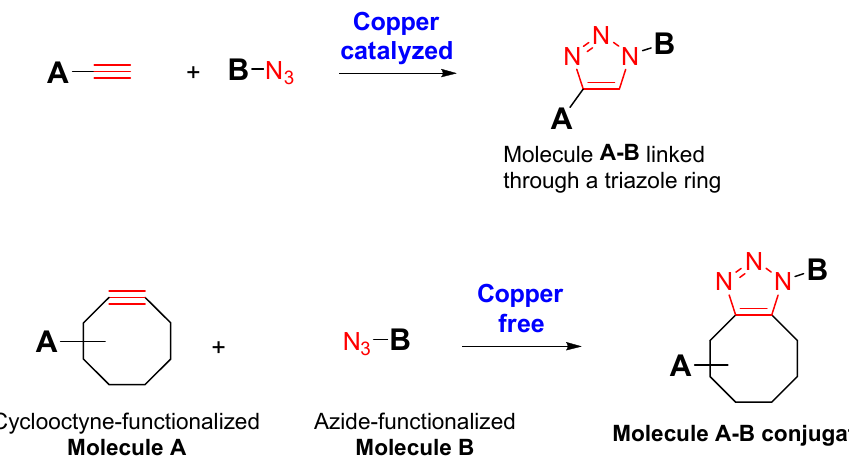
Figure 1. Overview of click chemistry reaction and SPAAC.